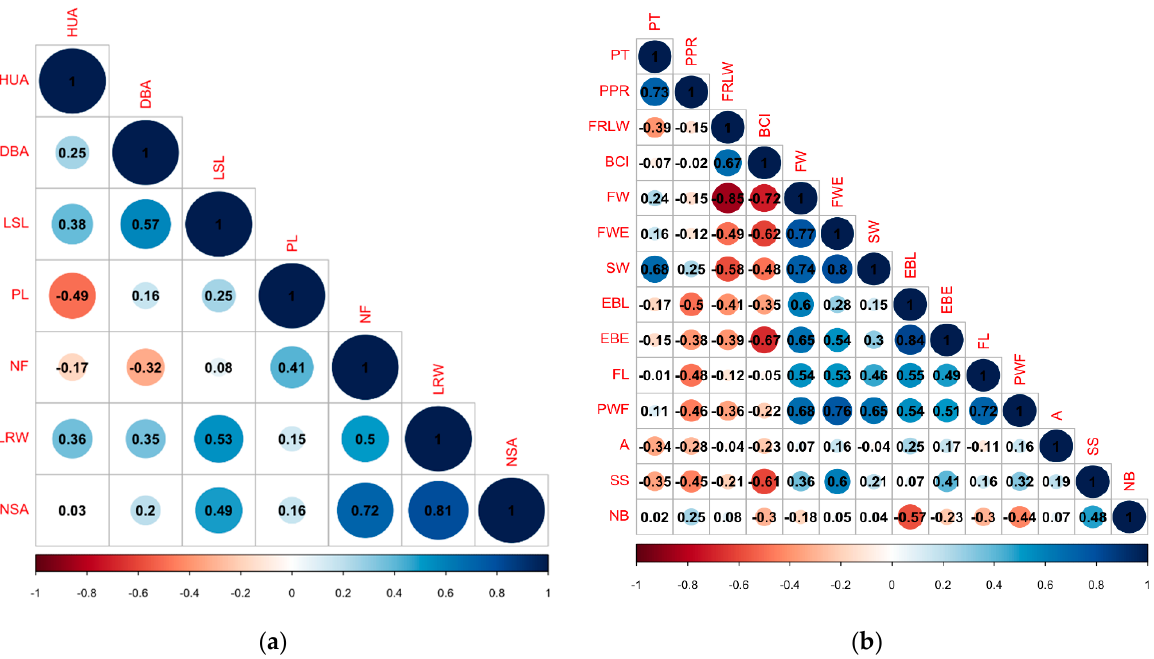
Figure 1. Spearman’s correlation between quantitative variables. ( a ) Morphoagronomic variables. ( b ) Fruit variables.